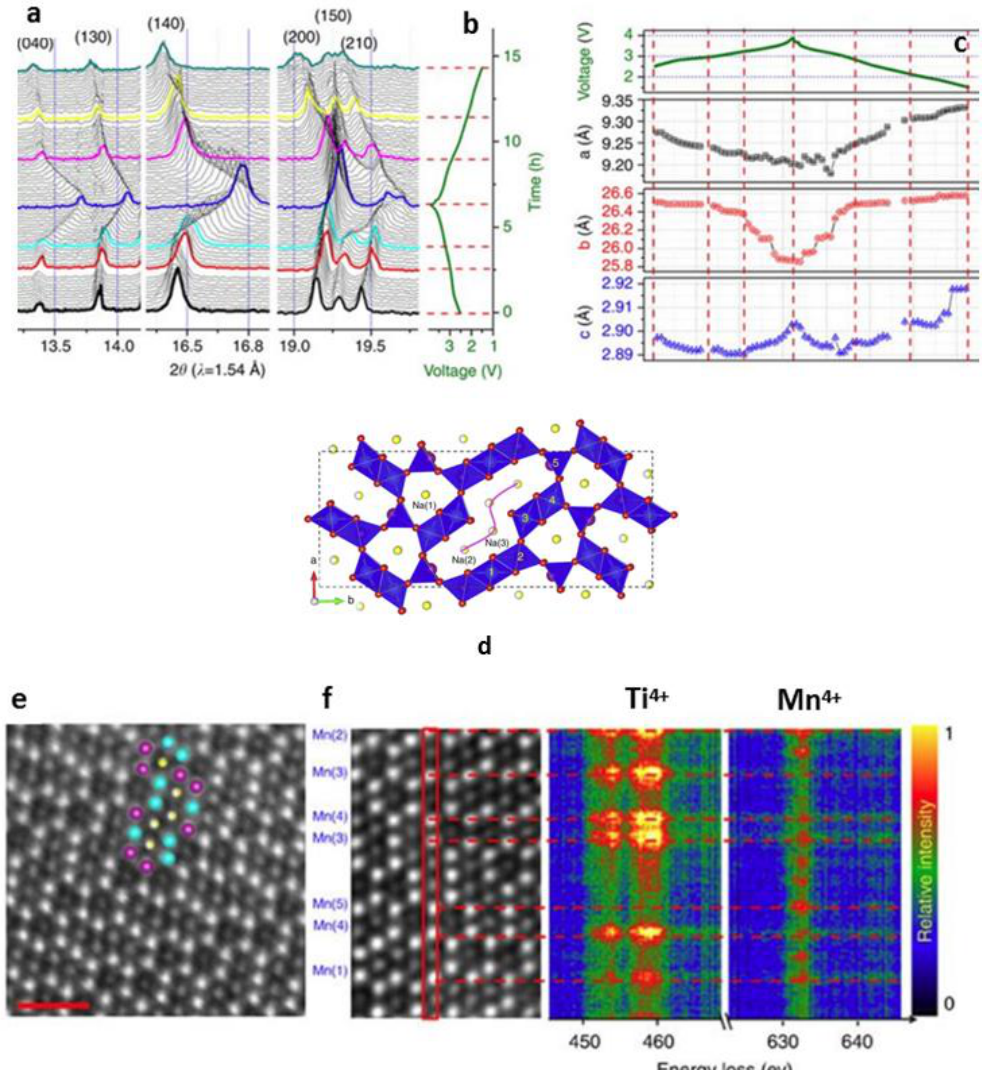
Figure 15. ( a ) Operando XRD patterns collected during the first charge-discharge of a Na/Na 0.44 [Mn 0.44 Ti 0.56 ]O 2 cell at C/10 rate between 1.5 and 3.9 V. ( b ) Charge-discharge curve. ( c ) Lattice parameter variations correspond to ( a ). ( d ) General structure view along c -axis showing five crystallographic sites for manganese and three sites for sodium. ( e ) HAADF-STEM image for as-prepared Na 0.44 [Mn 0.44 Ti 0.56 ]O 2 along [001] zone axis. ( f ) The EELS image of Na 0.44 [Mn 0.44 Ti 0.56 ]O 2 . Scale bar, 1 nm, [186]; with permission from Springer Nature.